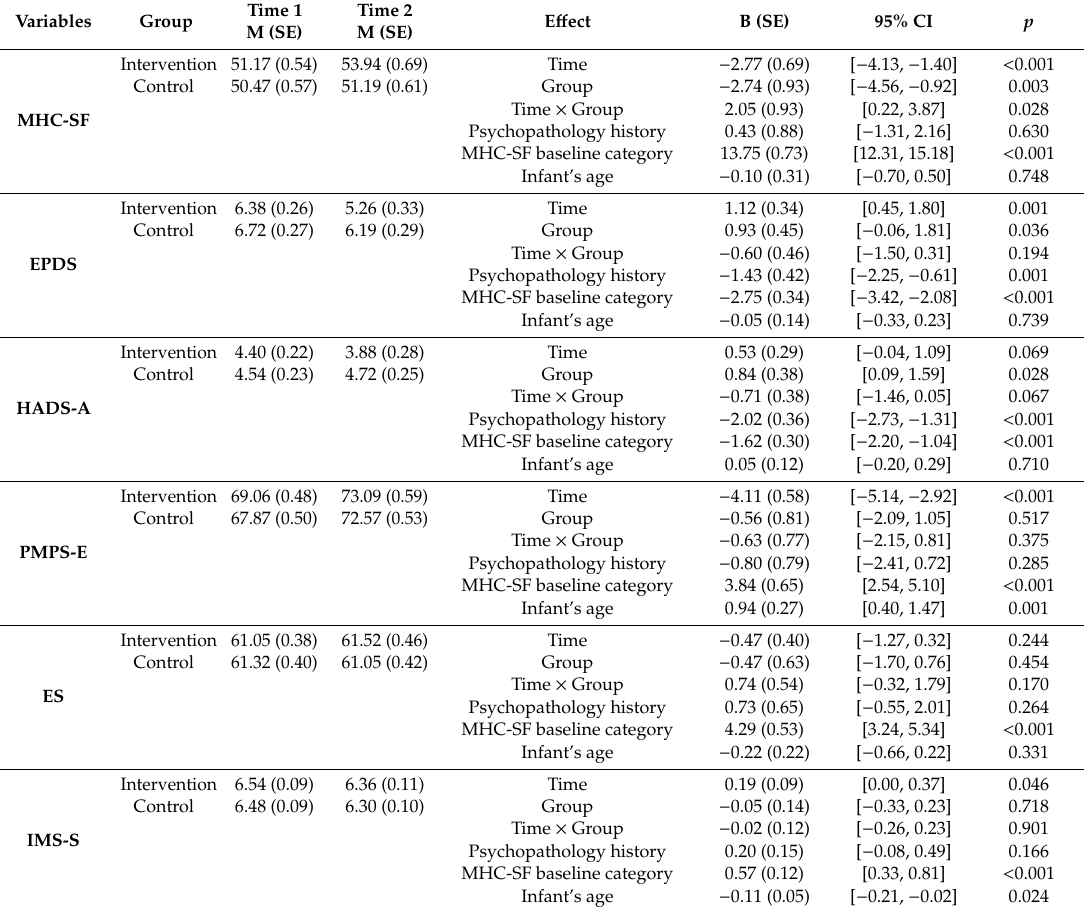
Table 2. Estimated marginal means and fixed e ff ects for primary and secondary outcome